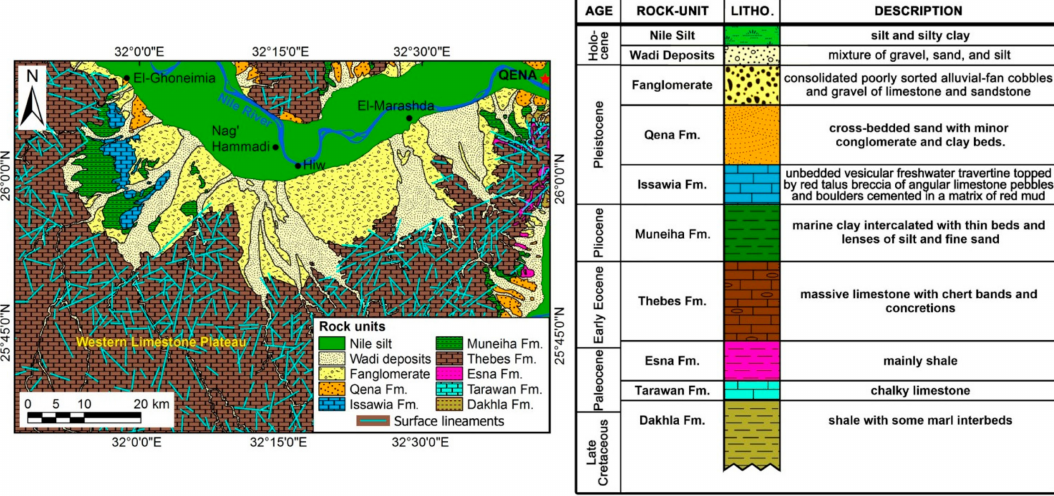
Figure 2. Geological map of the study area (modified after CONOCO and EGPC, 1987) and a composite stratigraphic column of the Nile Valley (Said, 1981; Omer, 1996; Issawi et al., 2009). The solid green color surrounding the River Nile represents the vegetation